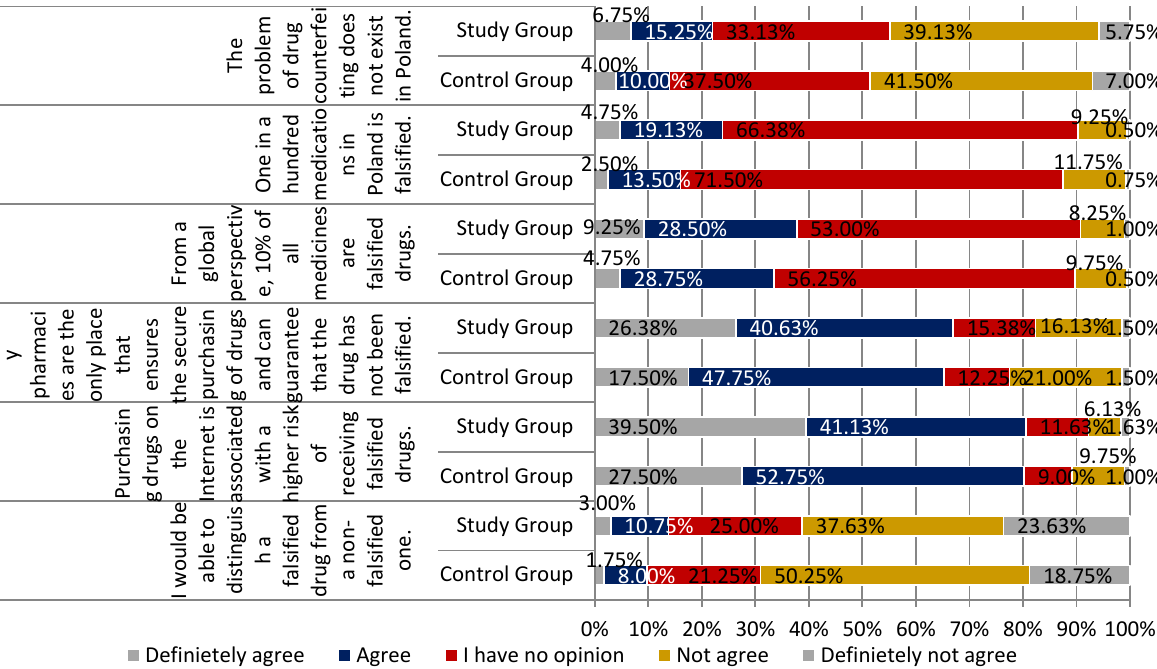
Figure 6. Falsified drugs in the opinion of respondents from study and control group part 2.